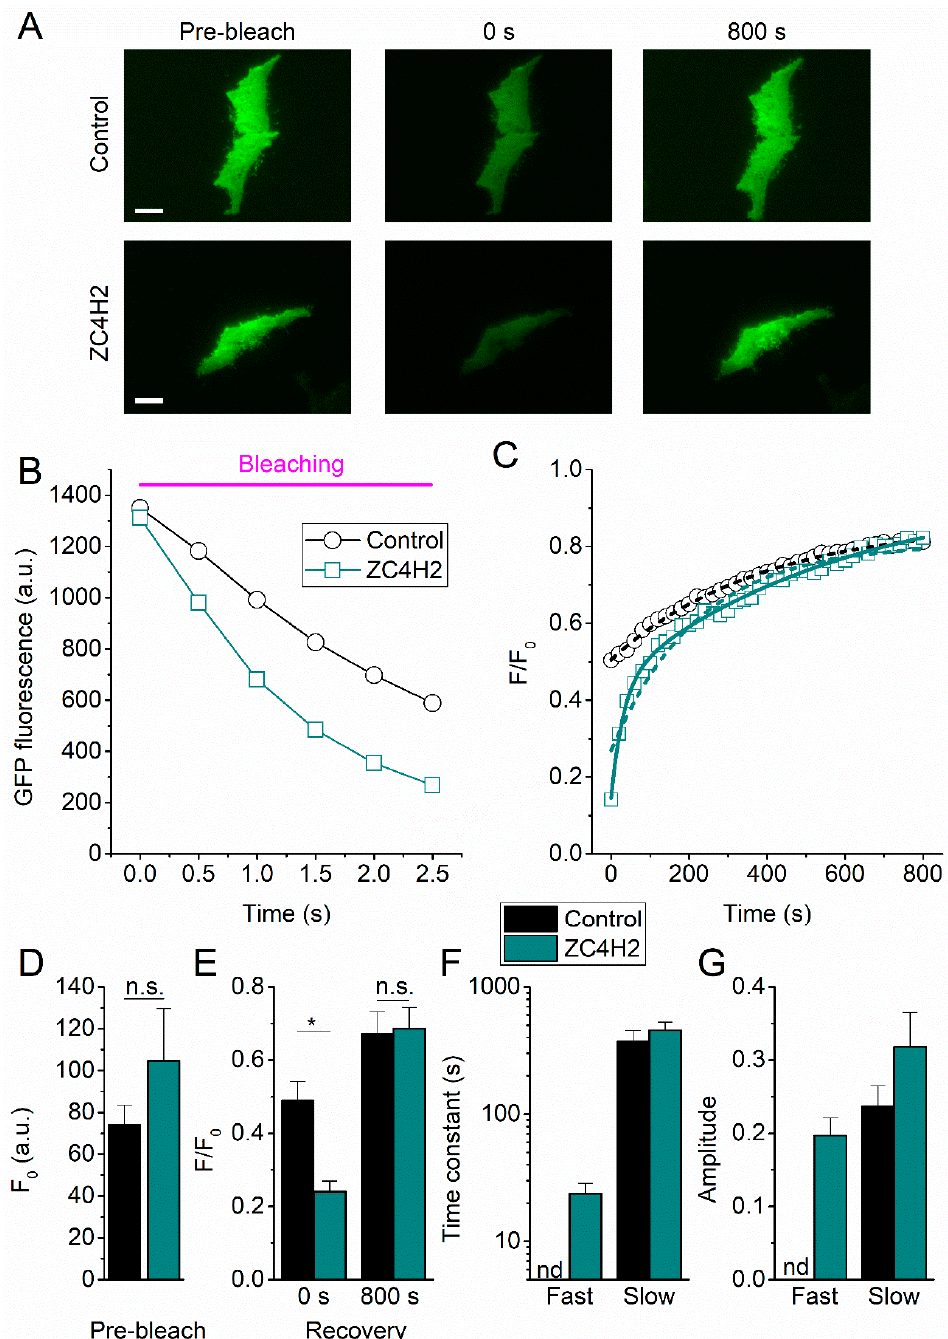
Figure 4. Effect of ZC4H2 on TRPV4 turnover at the plasma membrane assayed using TIR-FRAP. ( A ) TIRF images of TRPV4-GFP in HEK-293T cells co-expressing mCherry (control) or ZC4H2-mCherry. Images were taken before bleaching, and at 0 and 800s after bleaching. Scale bar = 10 µ m. ( B , C ) Time course of the decay of TRPV4-GFP fluorescence during the bleaching process ( B ) and the recovery of the fluorescence following bleaching ( C ) in representative cells expressing ZC4H2 or the control. Dotted and solid lines in C represent mono- and bi-exponential fits, respectively. ( D ) Mean basal TRPV4-GFP fluorescence before bleaching, in control and ZC4H2-expressing cells. ( E ) Mean TRPV4-GFP fluorescence at 0 and 800s after bleaching. ( F , G ) Time constants and corresponding relative amplitudes obtained from exponential fits to recovery time courses as in ( C ). In control cells, a mono-exponential fit was generally sufficient to describe the recovery process. In ZC4H2-expressing cells, adequate fitting required a second faster kinetic component. Number of cells in ( D – G ): control: n = 16; ZC4H2: n = 14. p -values < 0.05 were considered significant